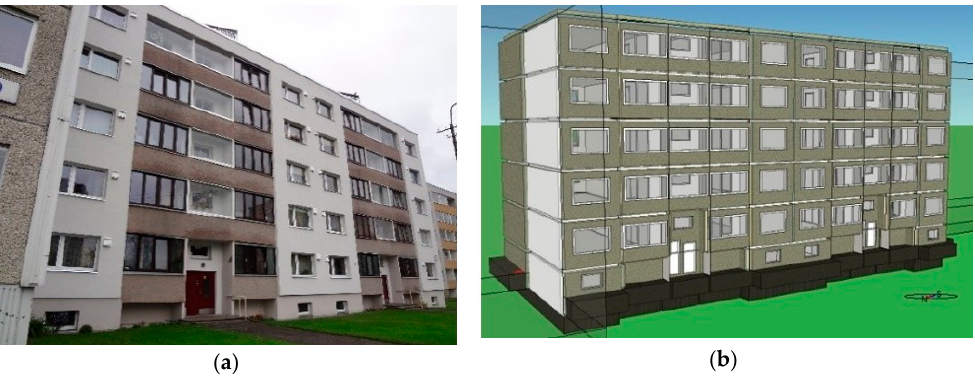
Figure 6. The studied ( a ) apartment building and ( b ) the simulation model.